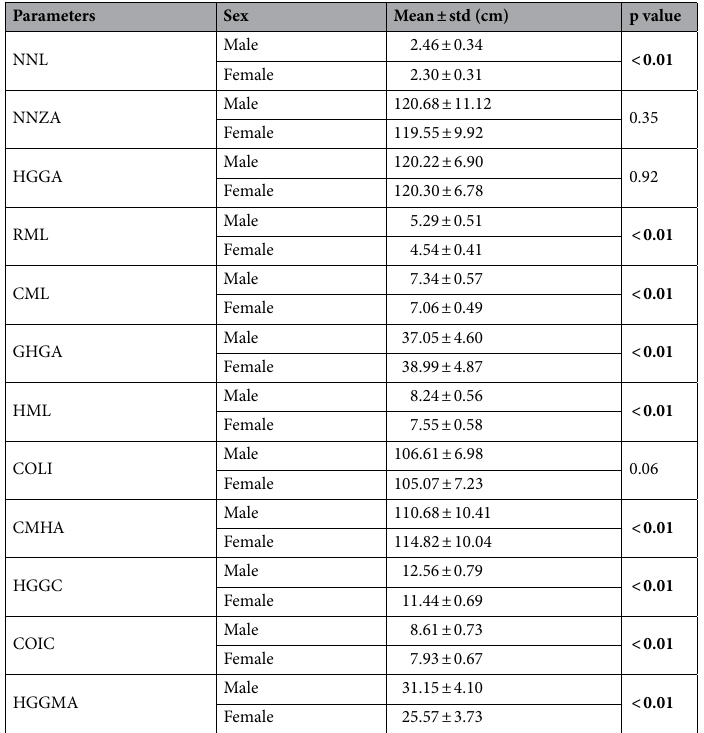
Table 1. Comparison of parametric data of males and females. NNL: Nasion–nasal end point length, NNZA: Nasal end point–nasion–zygomatic angle, HGGA: Head of mandible– gonion–gnathion angle, RML: Ramus of the mandible length, CML: Corpus of the mandible length, GHGA: Gnathion–head of mandible– gonion angle, HML: Head of mandible–mental foramen length, COLI: Coronoid process–obliqua line–infradental angle, CMHA: Coronoid process–mandibular notch–head of mandible angle, HGGC: Head of mandible– gonion–gnathion curvature length, COIC: Coronoid process–obliqua line–infradental curvature